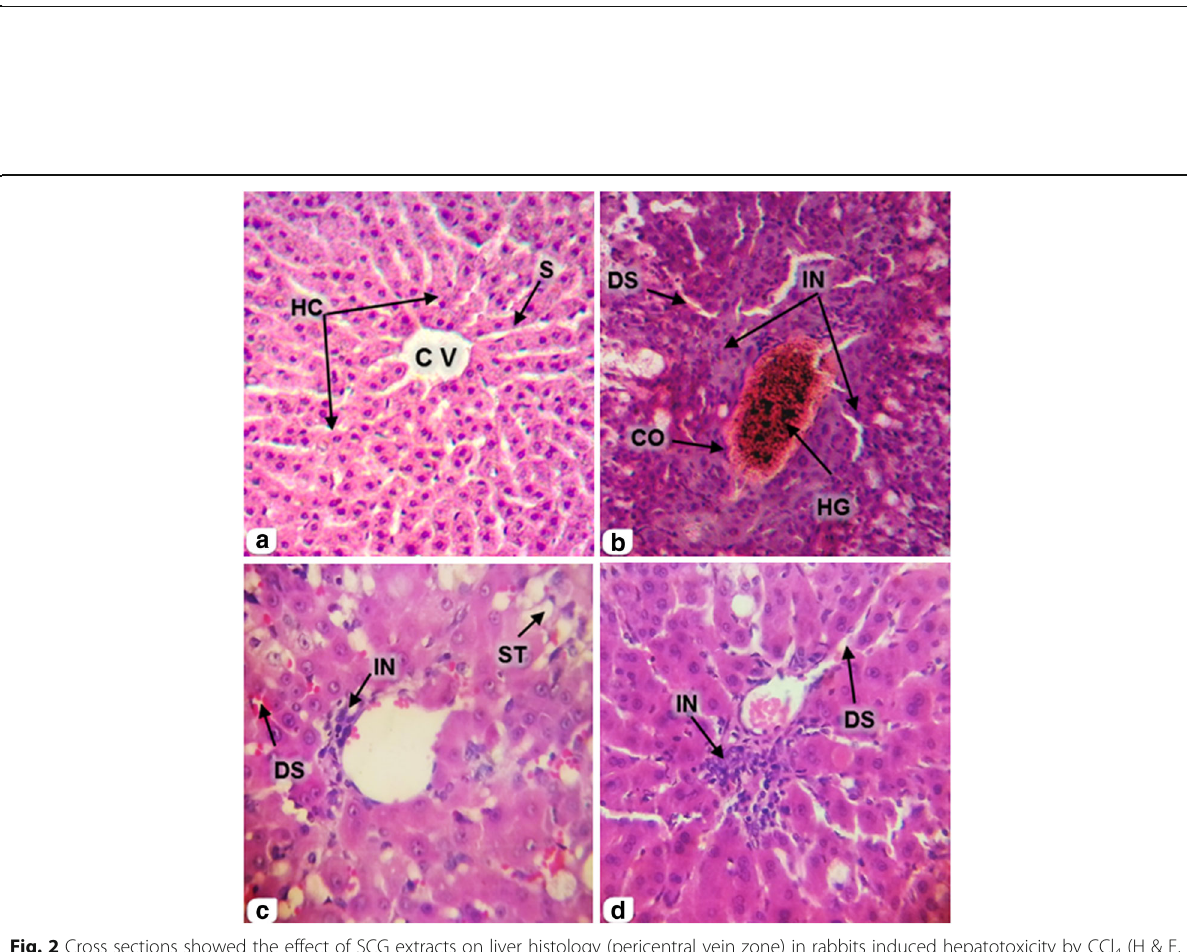
Fig. 2 Cross sections showed the effect of SCG extracts on liver histology (pericentral vein zone) in rabbits induced hepatotoxicity by CCl 4 (H & E, 100X). a : Is Control group (C) (normal control); b : is CCl 4 group (T); c : is CCl 4 + SCG group (TS) and d : is CCl 4 + MCG group (TM). Hepatocytes (HC), Central vein (CV), Sinusoid (S), Congested central vein (CO), Deposition of haemosedrine granules (HG), dilated sinusoid (DS), Cellular inflammation (IN) and Steatosis